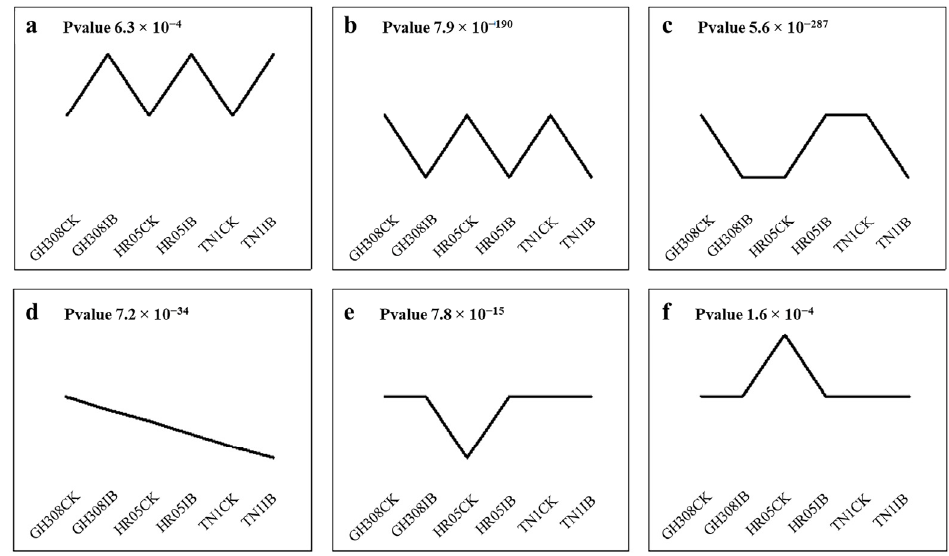
Figure 4. Six expression patterns ( a – f ) of DEGs were found in different rice samples. GH308, HR05, and TN1 are the three rice varieties. CK indicates control samples. IB represents rice samples that were infected by BHPs. Each module was statistically significant, with p values < 0.05.